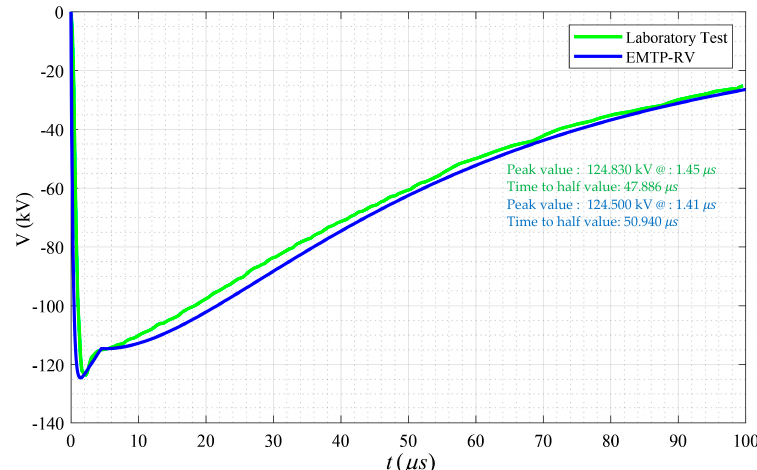
Figure 6. Generated lightning impulse voltage by connecting two surges in series, 125 kV, Laboratory Test and EMTP-RV model.